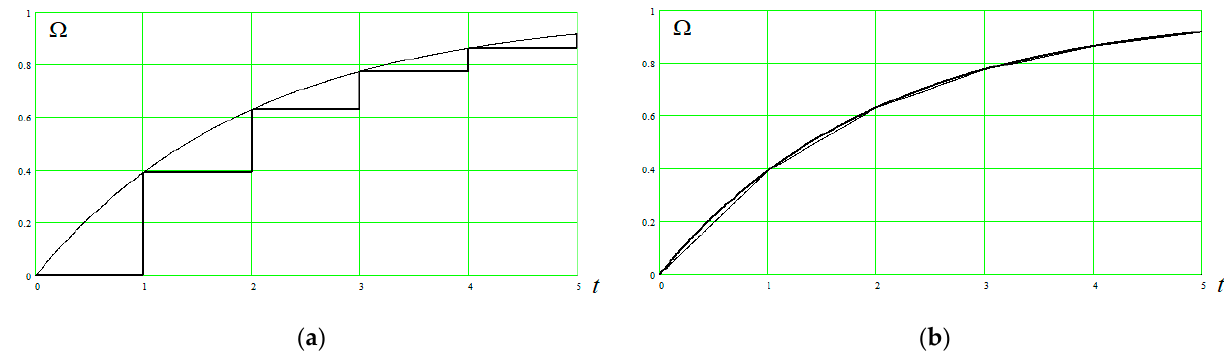
Figure 2. ( a ) Stepwise and ( b ) linear piecewise approximations of the model angular rate.